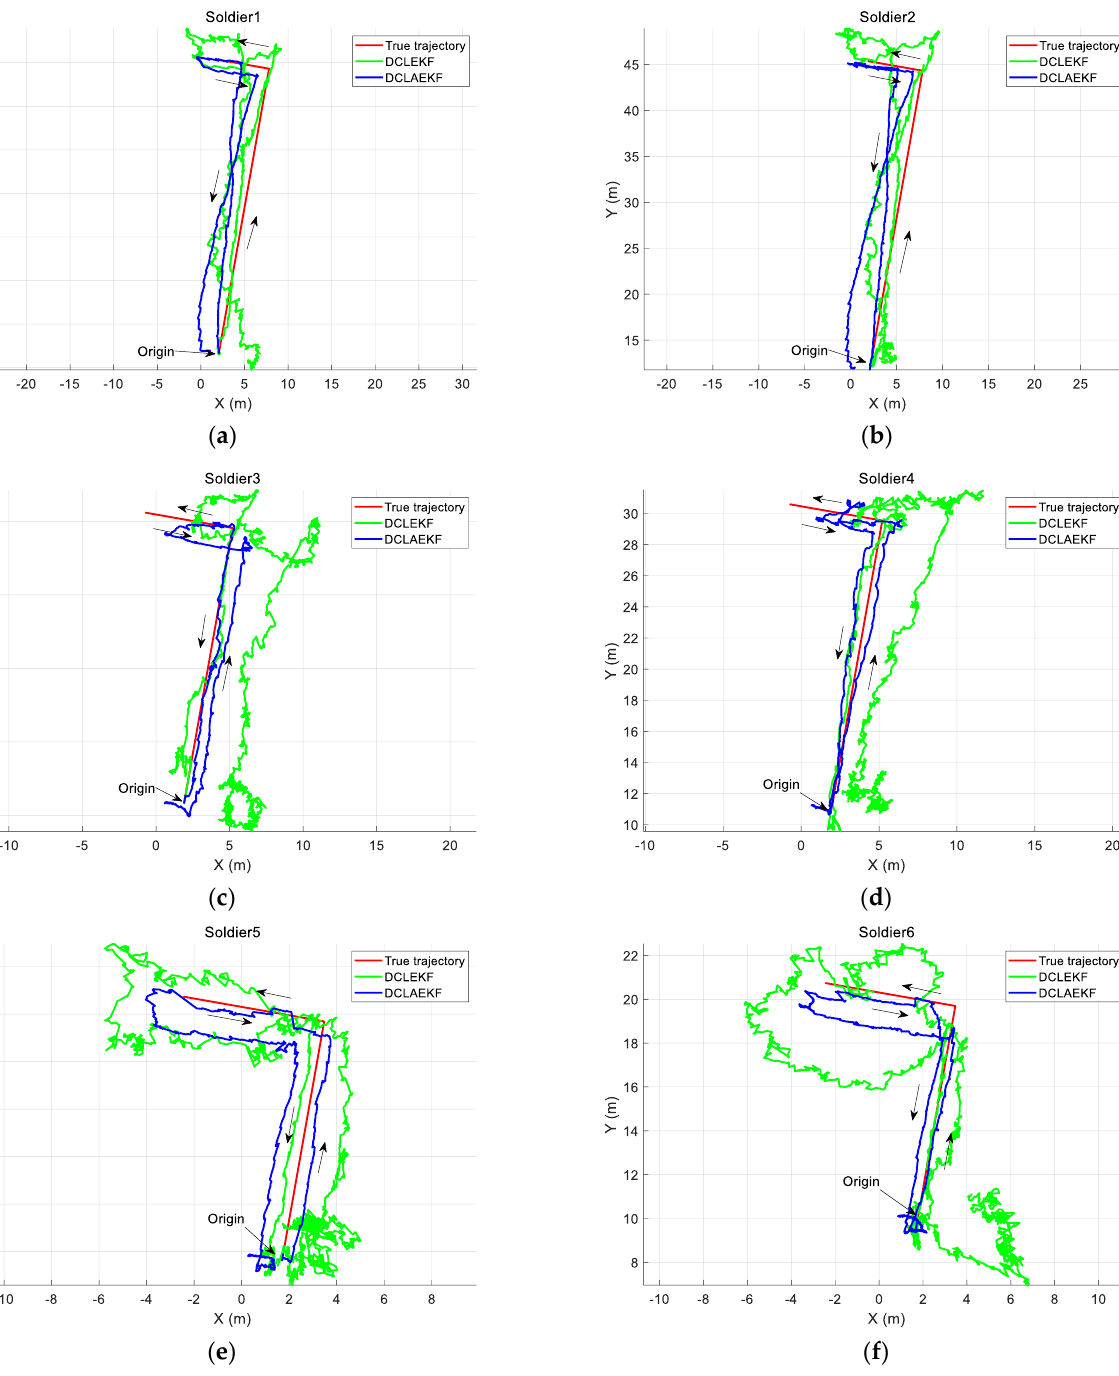
Figure 9. Reference track diagram in the forest environment.